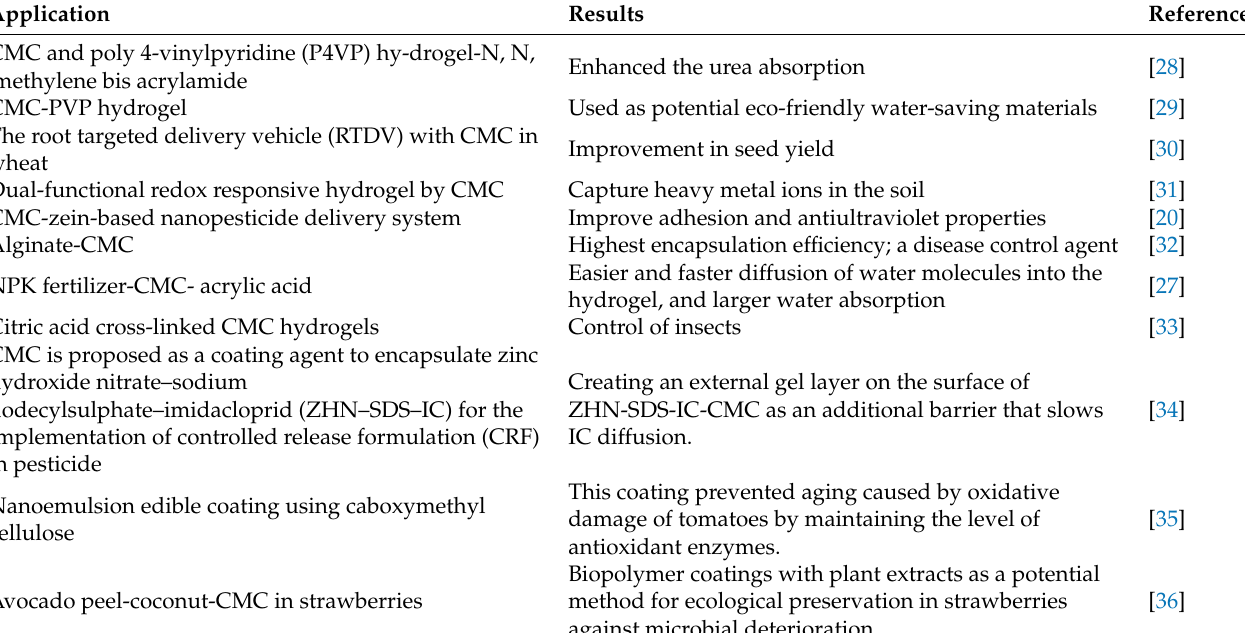
Table 1. A summary of the application of CMC in